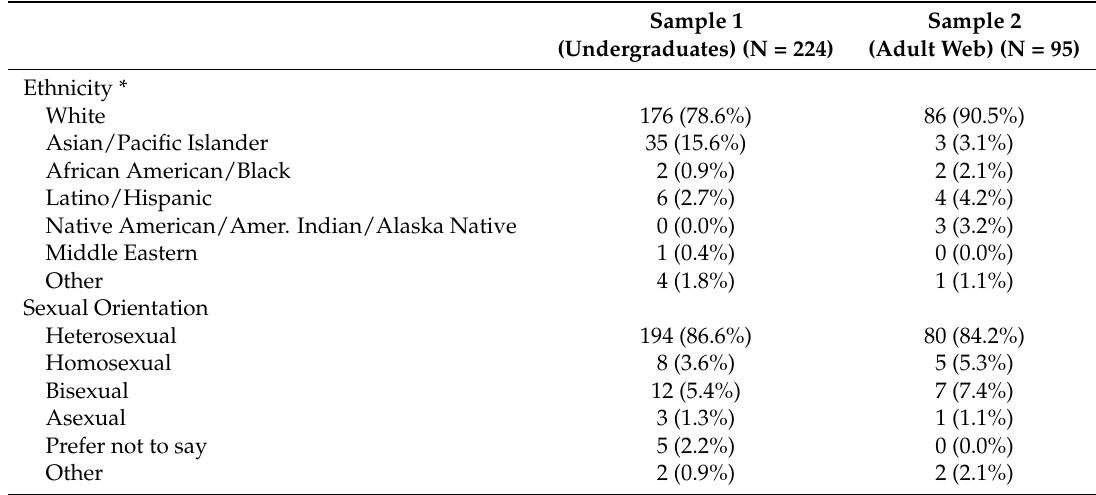
Table 1. Demographic Variables: Atheist Samples 1 and